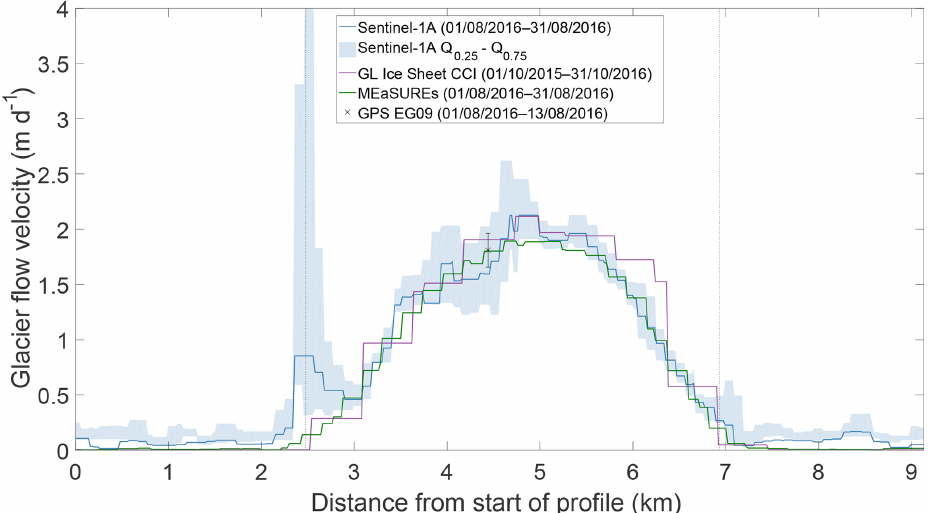
Figure A7. Mean flow speed across the position of GPS tracker EG09 (see Fig. 1) derived from S1A scenes acquired between 1 and 31 August 2016 (1 month), starting at the orographic left side of the glacier. Reference flow velocities from MEaSUREs and Greenland Ice Sheet CCI products are shown in green and purple. The dashed lines depict the glacier’s margins. Note the peak at the orographic left margin emerges from a debris covered marginal moraine.